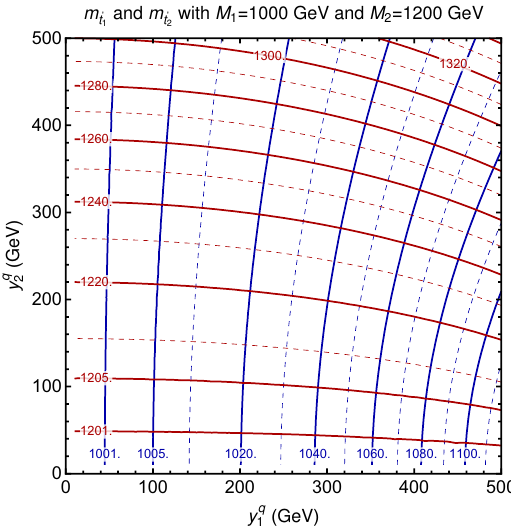
Figure 5 . Masses in GeV of t 0 (blue contours) and t 0 (red contours) mixing with the light quarks, 1 2 for the benchmark M 1 = 1000 GeV and M 2 = 1200 GeV. The contours are shown at intervals of 10 GeV unless speci(cid:12)ed. Results for mixing with the top quark are numerically almost